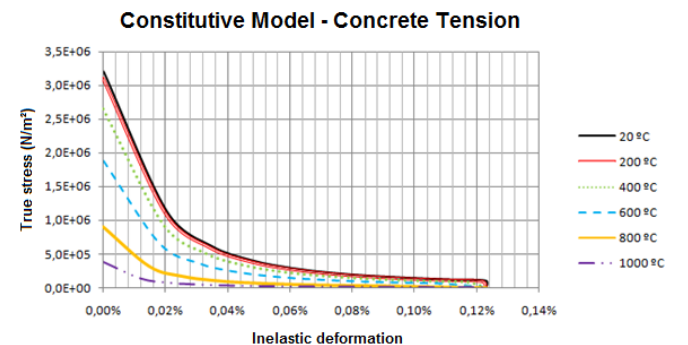
Figure 7. Concrete mechanical properties under tension.